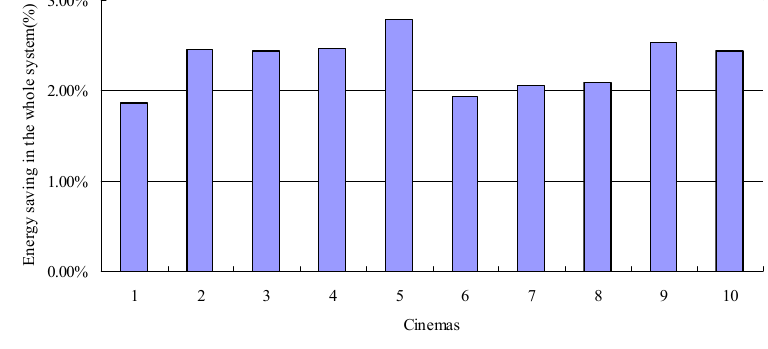
Figure 5. Overall energy saving percentages in the whole